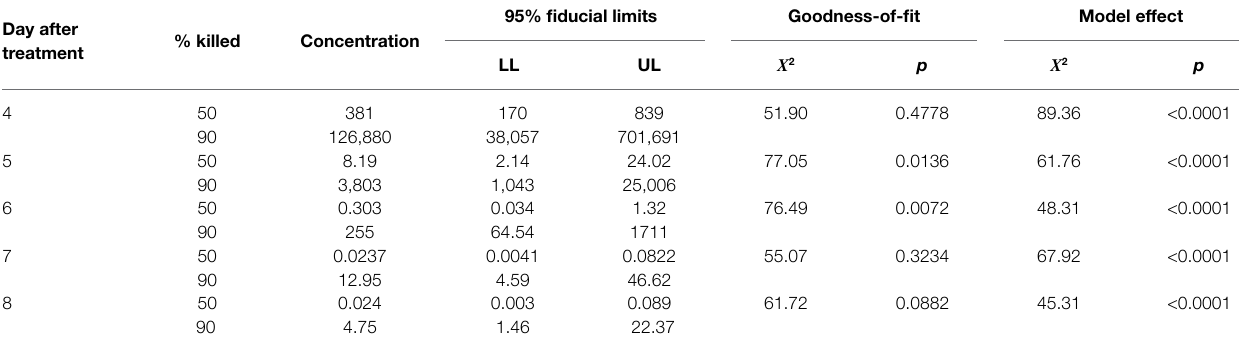
TABLE 2 | Lethal days for 50 and 90% of the second-instars CPBs exposed to dsRNA. Concentration % killed Days